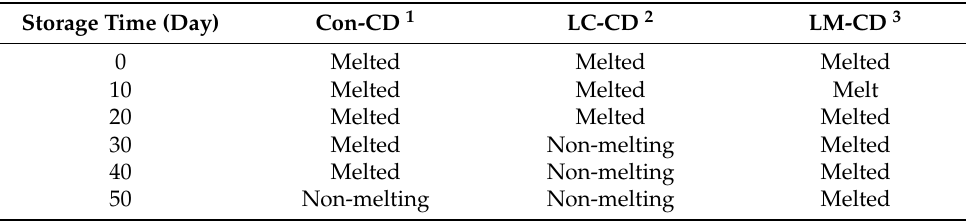
Table 3. Meltability test of cheese- ddukbokki rice cake samples during 50 days at 10 ◦ C.